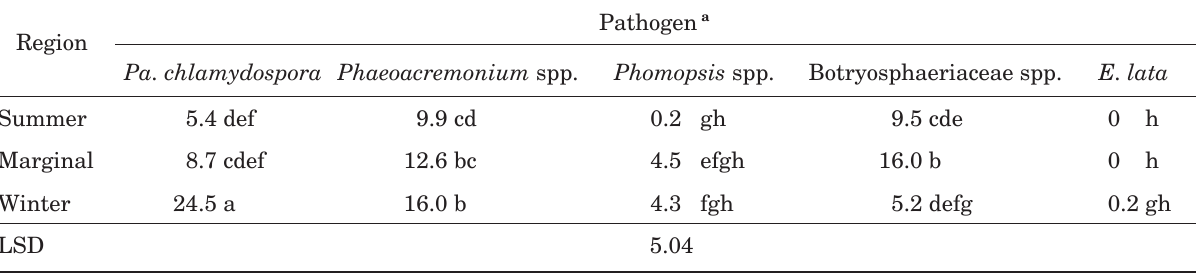
Table 1. Mean incidence of Phaeomoniella chlamydospora , Eutypa lata and species in the Botryosphaeriaceae, Pho- mopsis and Phaeoacremonium isolated from vines in the summer, marginal and winter rainfall regions of South Africa.